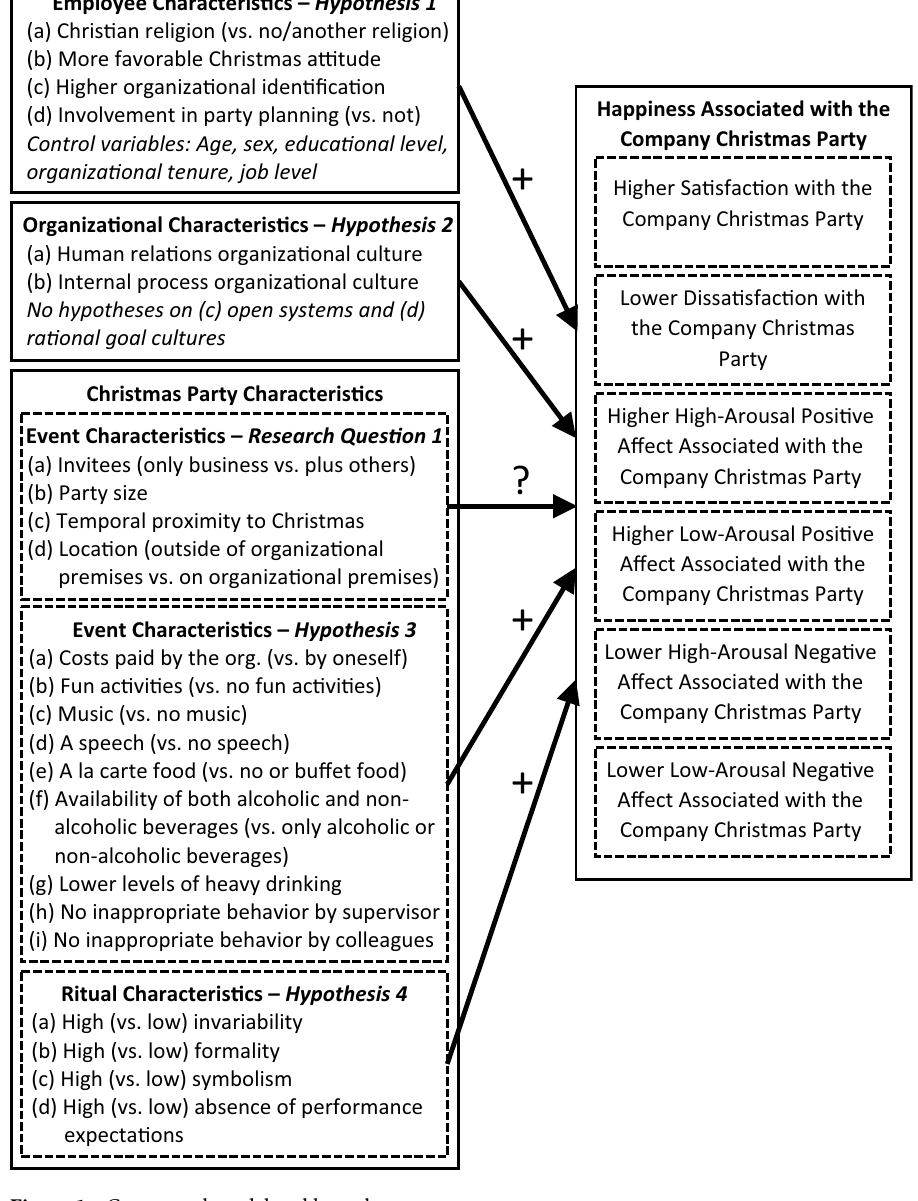
Figure 1. Conceptual model and